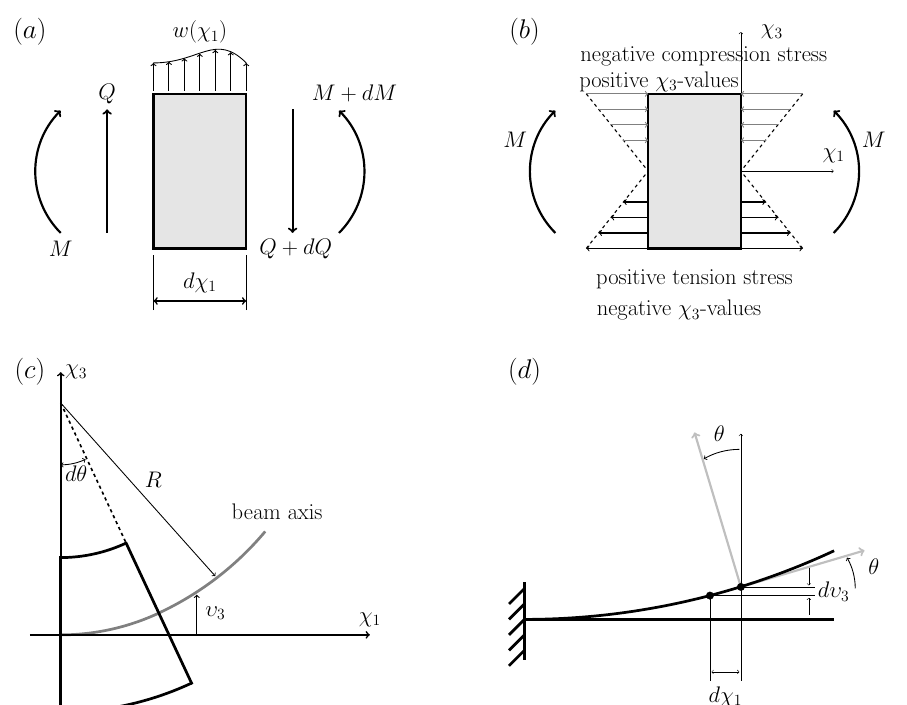
Figure 3. Strains, displacements and rotations on Euler-Bernoulli Beam, ( a ) equilibrium for in- finitesimal beam element, ( b ) axial stress over the cross section, ( c ) a beam segment in bending and ( d ) rotation of the cross section of a beam